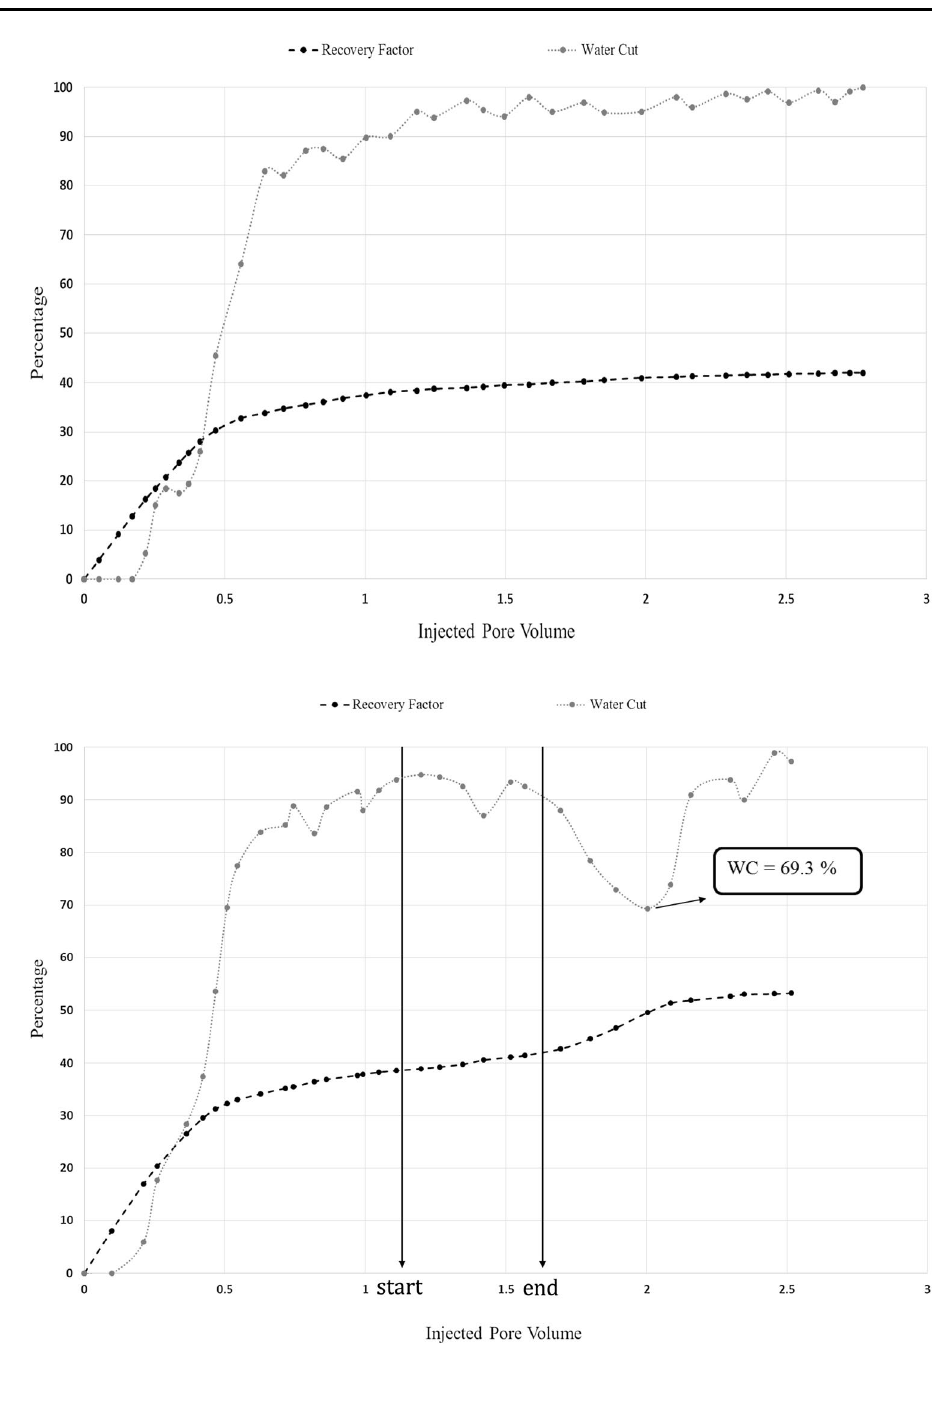
Fig. 4 Cumulative oil recovery and water cut during SW injec- tion (test 1)